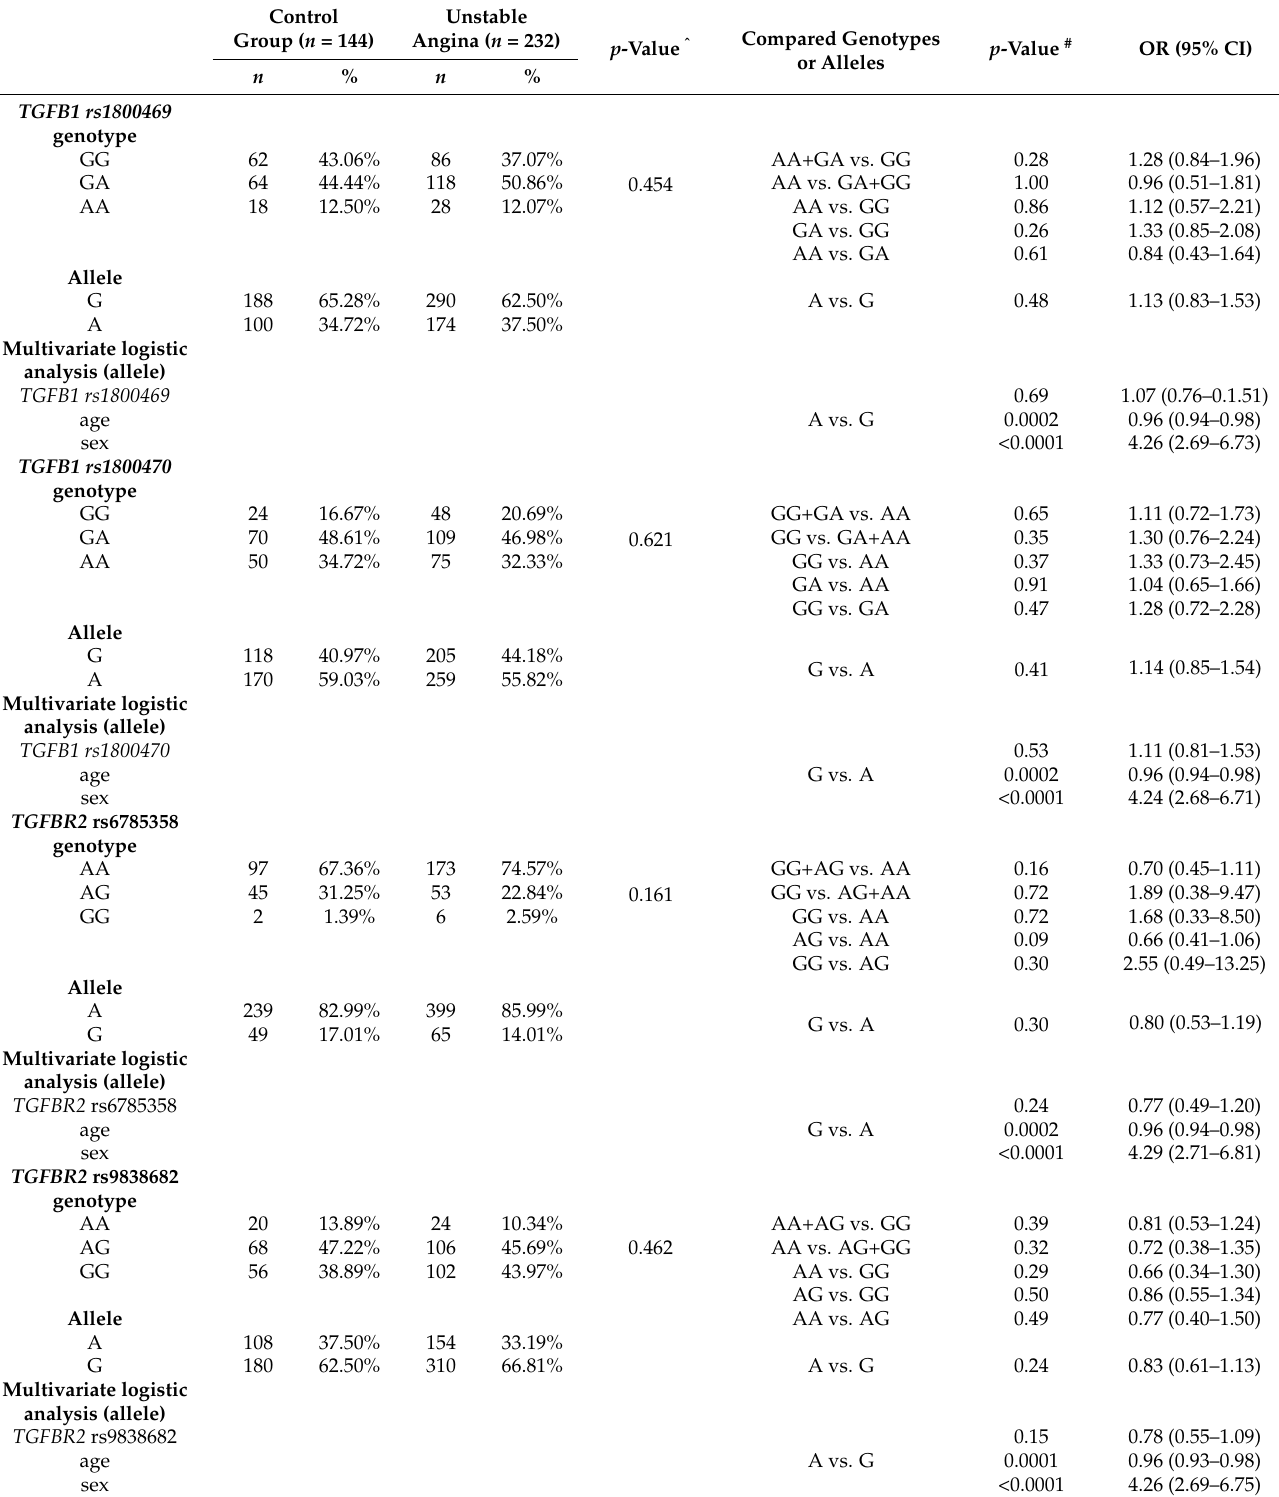
Table 3. Distribution of TGFB1 rs1800469, rs1800470, and TGFBR2 rs6785358, rs9838682 genotypes and alleles in patients with unstable angina and